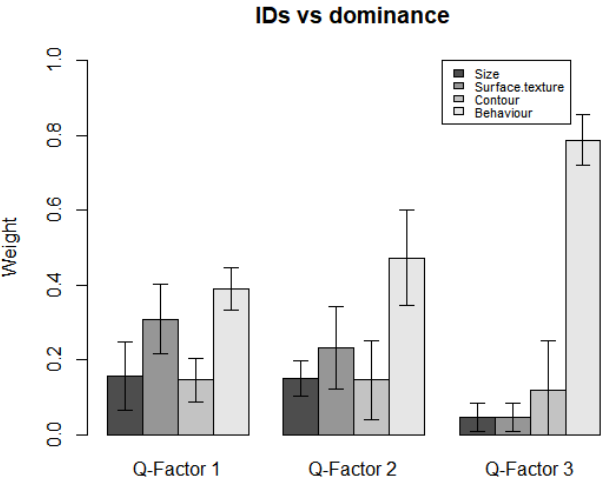
Figure 12. The interaction between individual differences and dominance.